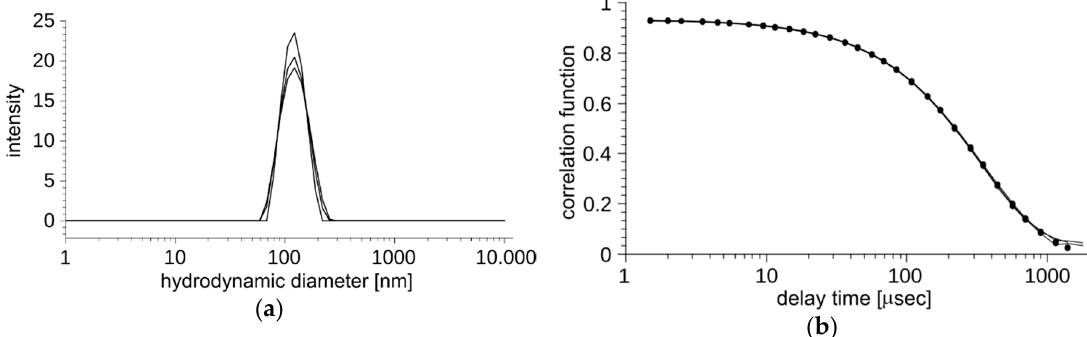
Figure 2. The homogeneity of a population of vesicles encapsulating Photolon. ( a ) Vesicle size distribution obtained from the dynamic light scattering (DLS) experiment; ( b ) quality of the fit of the single population model to an experimentally derived autocorrelation